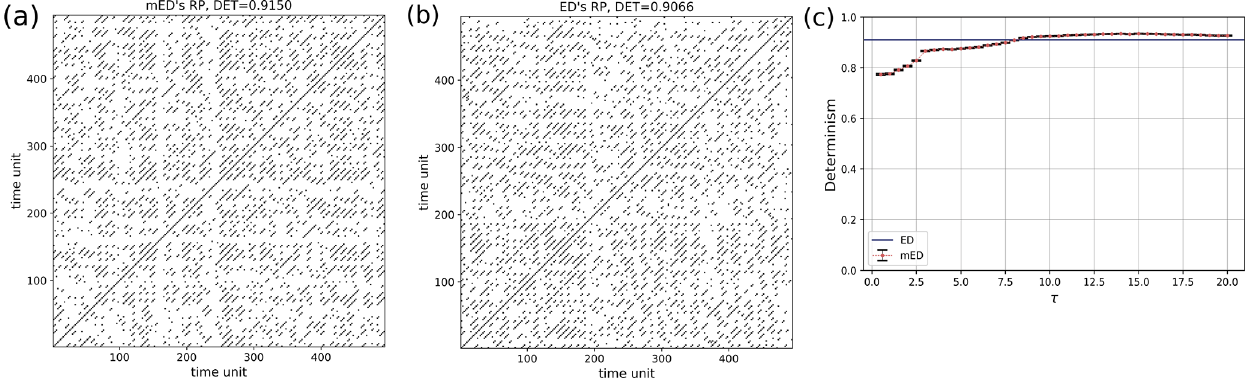
Figure 10. RP of the Poisson process with periodical forcing (Fig. 7c) using (a) mED and (b) ED; (c) comparison of DET for 300 realizations using ED (blue horizontal line) and using mED for varying τ in the range 0 to 20.